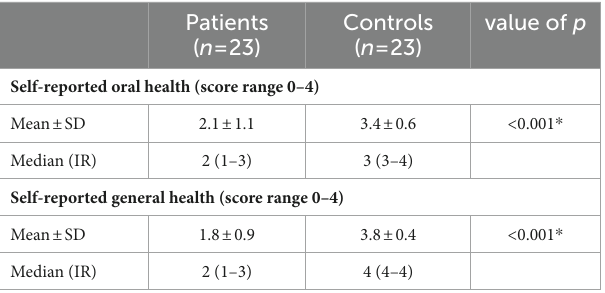
TABLE 3 Results from the self-reported rating of oral and general health on a scale from 0 to 4, 0 = very bad and 4 = very